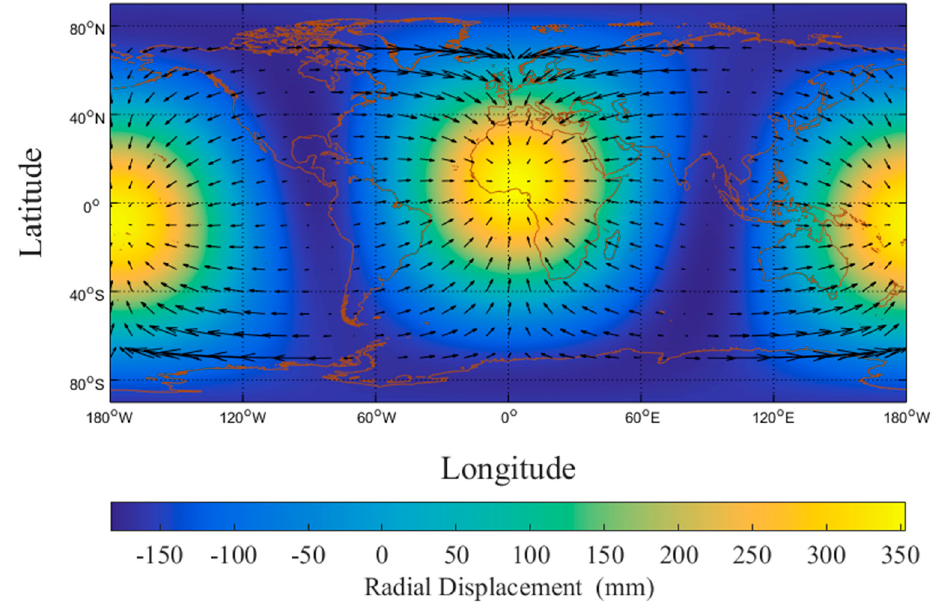
Figure 4. Global displacement distribution at 0:00 on 2 March 2018. The black arrows represent the direction of the horizontal displacement. The vertical displacement is from the earth’s center and distinguished by different colors. In order to retain the information of various gradients, the latitudinal and longitudinal density of the displacement distribution should be no less than 0.5°. This figure was generated in MATLAB with a density of 0.1°.